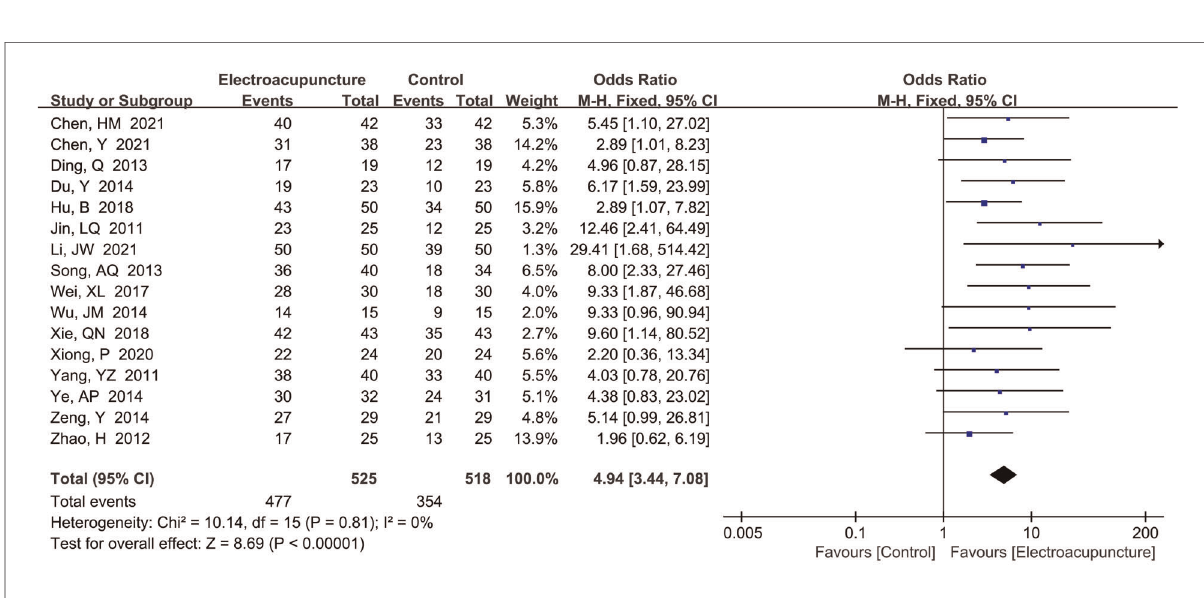
FIGURE 12 A forest plot showing the total effective